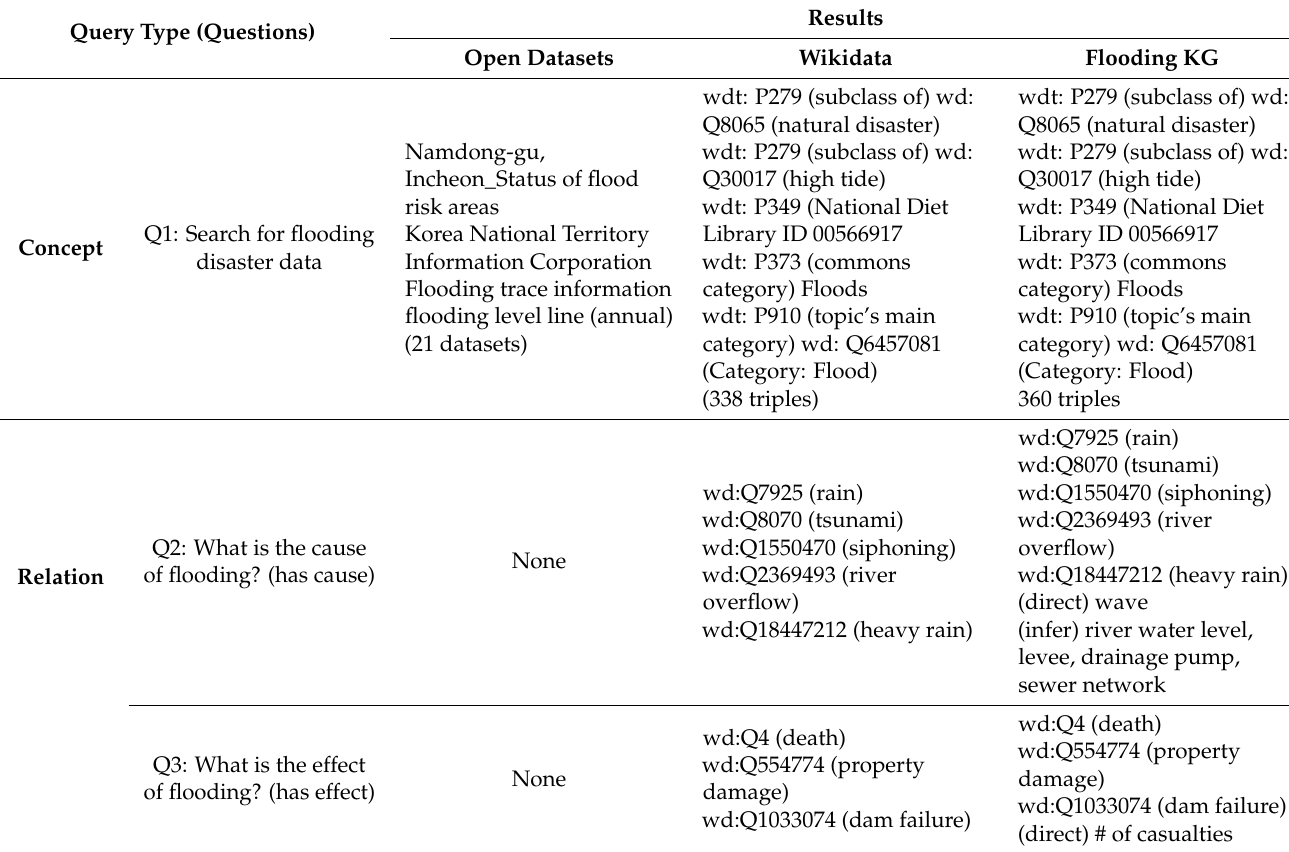
Table 2. Descriptions of the principal datasets selected from the open dataset related to flooding